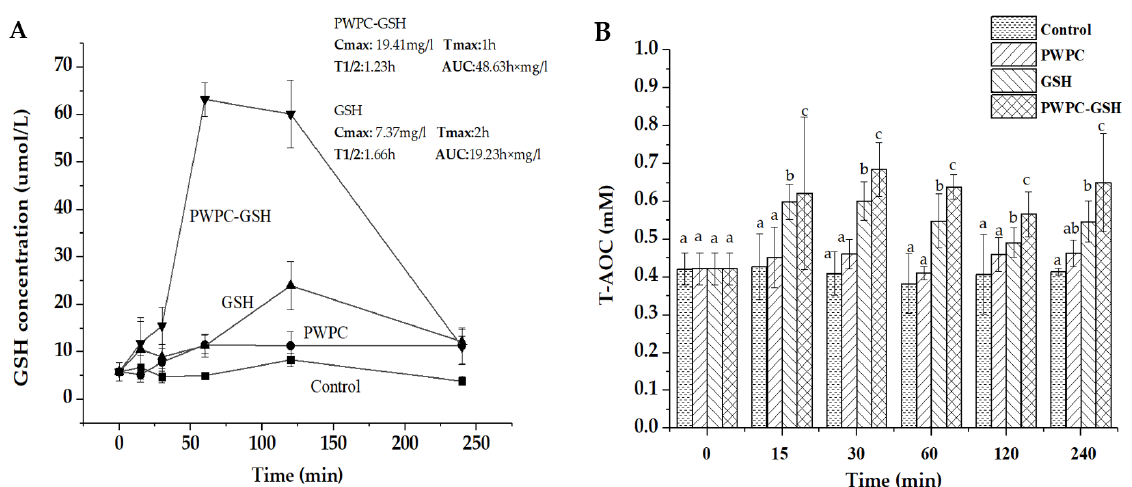
Figure 3. ( A ) GSH concentration ( µ M) in plasma of mice after oral administration of normal saline (control), PWPC, GSH, and PWPC-GSH. ( B ) In vivo antioxidant activity of plasma of mice after oral administration of normal saline (control), PWPC, GSH, and PWPC-GSH measured by an assay kit (ABTS method). In Figure 3B, completely different letter between samples at the same timepoint means significant difference ( p < 0.05).